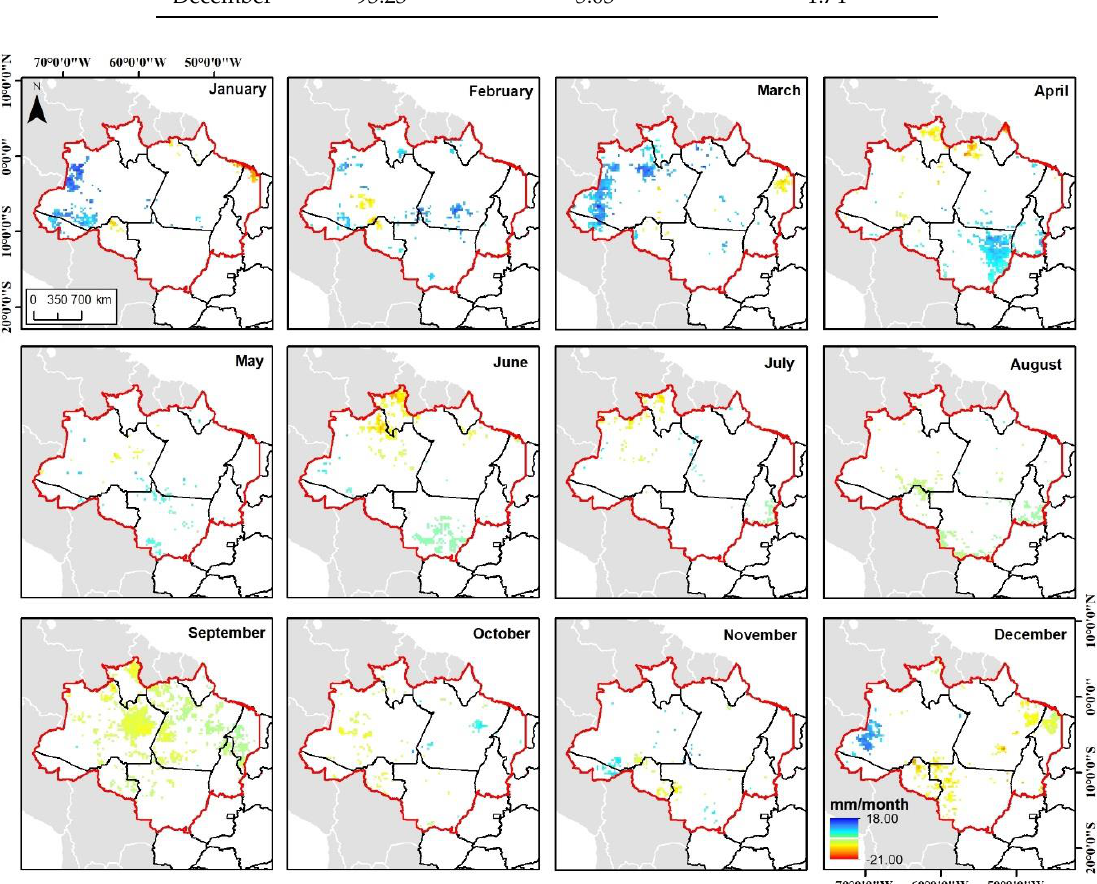
Figure 4. Spatial distribution of significant monthly rainfall trends (Sen’s slope; p ≤ 0.05). The positive trends are in blue and the negative trends are in red.